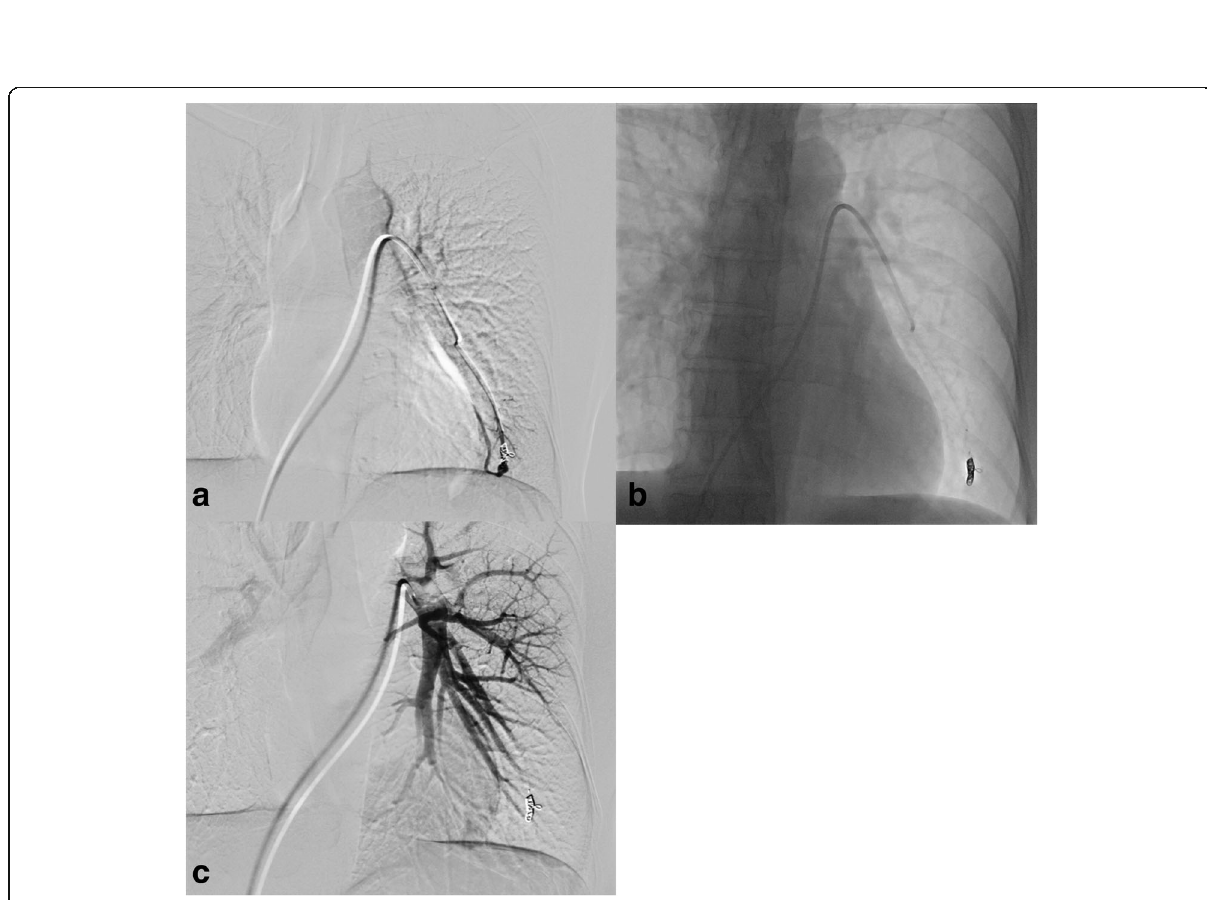
Fig. 2 a After coil deployment, there was still flow in PAVM. b and c An additional MVP-3Q was deployed, and the flow stopped immediately